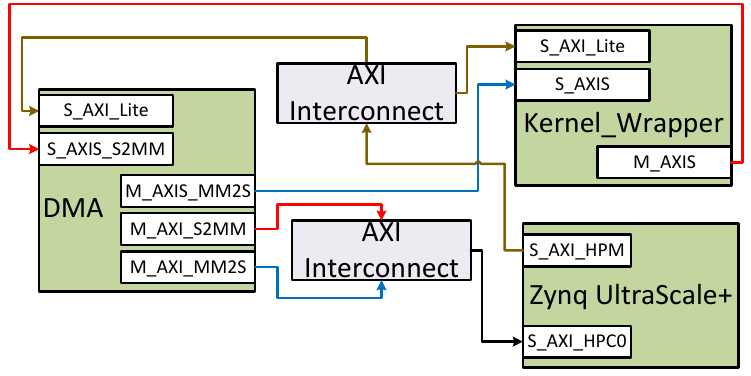
Figure 1. An overview of the system, including Zynq processor, DMA, Kernel_Wrapper module, and two